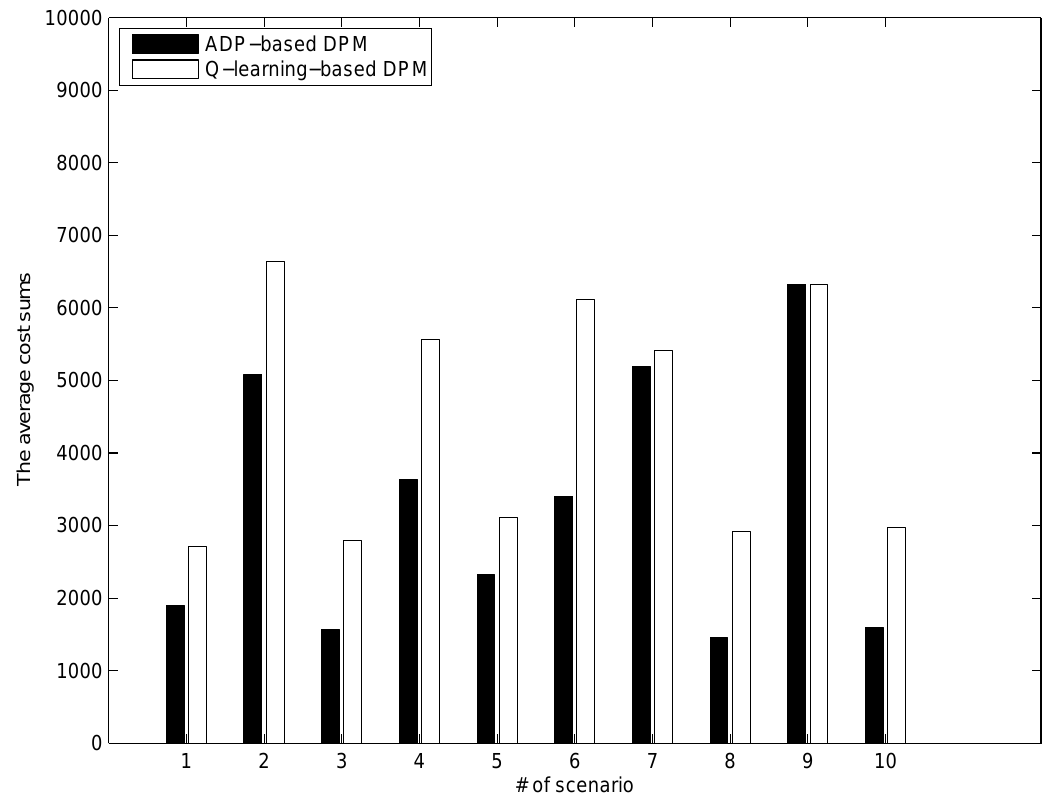
Figure 6. Performance comparison for ADP and Q: Average total cost for each